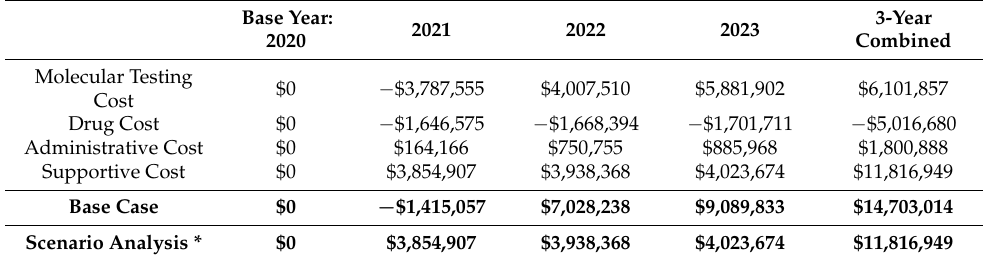
Table 10. Budget impact—base case and scenario analysis.